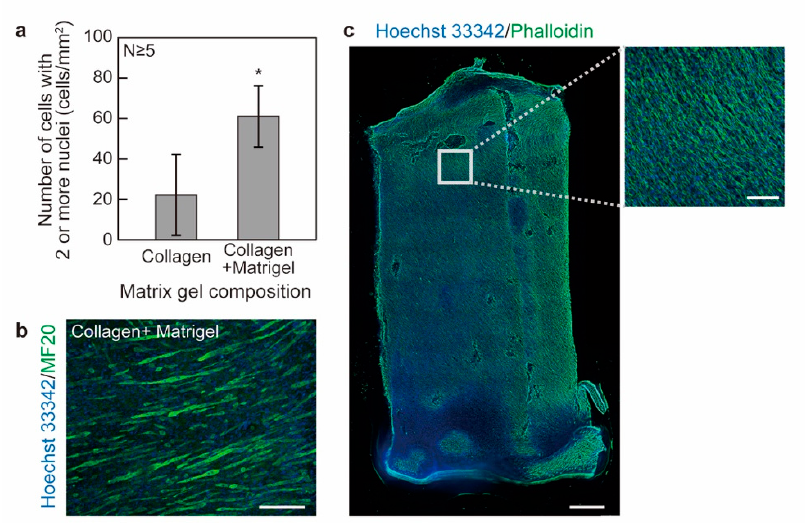
Figure 3. Optimization of the hydrogel composition to facilitate myogenic differentiation. ( a ) The numbers of cells with two or more nuclei per area for the tissues fabricated with/without the addition of Matrigel. * P ≤ 0.05, Welch’s t -test (N ≥ 5). ( b ) A representative image of the tissue stained with Hoechst 33342/MF20. ( c ) Tile scan of a whole piece of tissue stained with Hoechst 33342/Phalloidin. The inset shows a magnified image of the tissue in the rectangular region. Scale bars: ( b ) 200 µm, ( c ) 500 µm (inset: 100 µm).